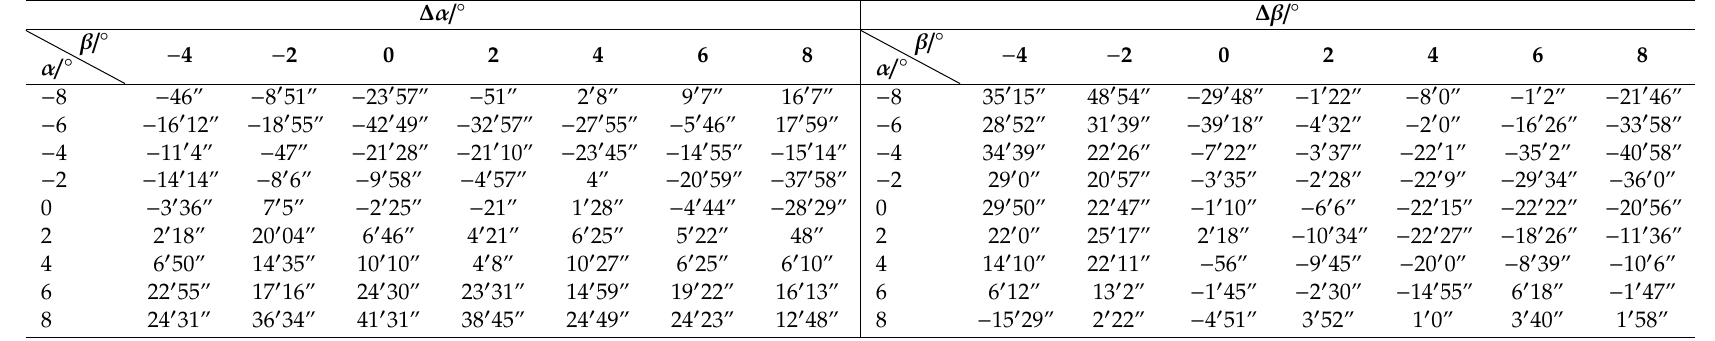
Table 1. Measurement error distribution chart of α and β ( − 8 ◦ < α < 8 ◦ , − 4 ◦ < β < 8 ◦ ). ∆ α / ◦ ∆ β / ◦